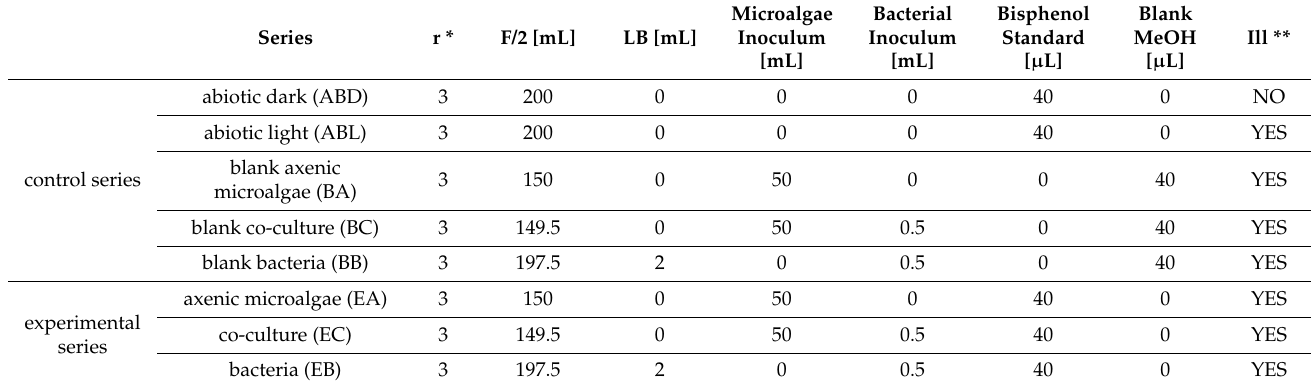
Table 1. Preparation of series used in the experiment.